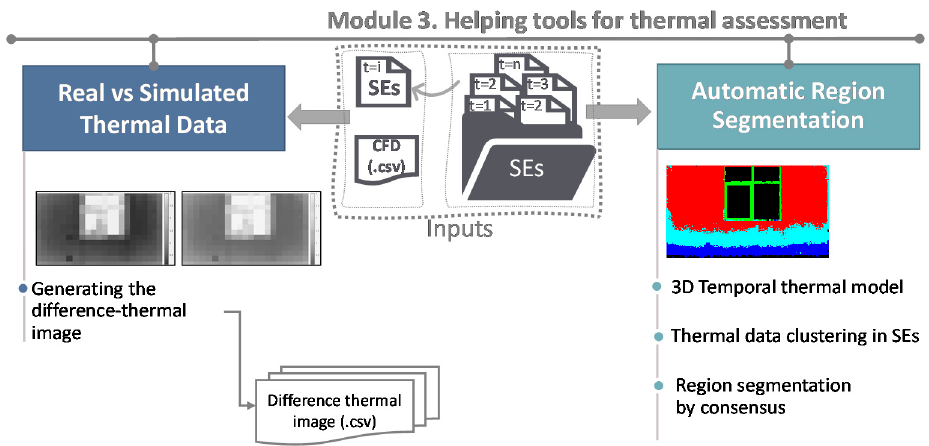
Figure 7. Diagram of the tools and functionalities of Module 3.